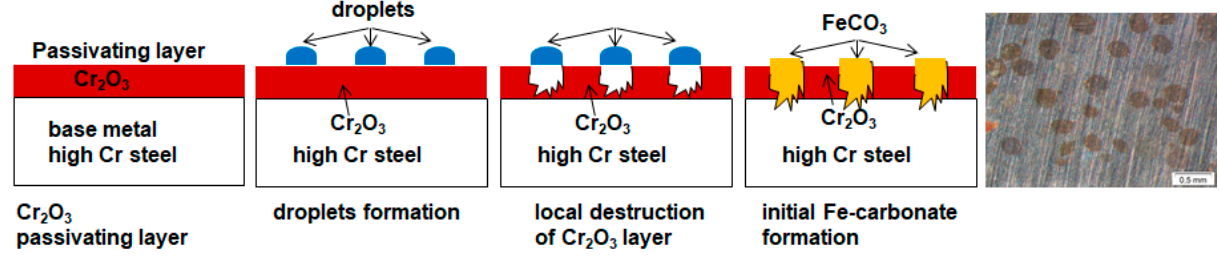
Figure 16. Schematic drawing of the precipitation of the corrosion layer on X5CrNiCuNb16-4 (1.4542) and an example of sample surfaces after 8000 h of exposure to water saturated supercritical CO 2 .